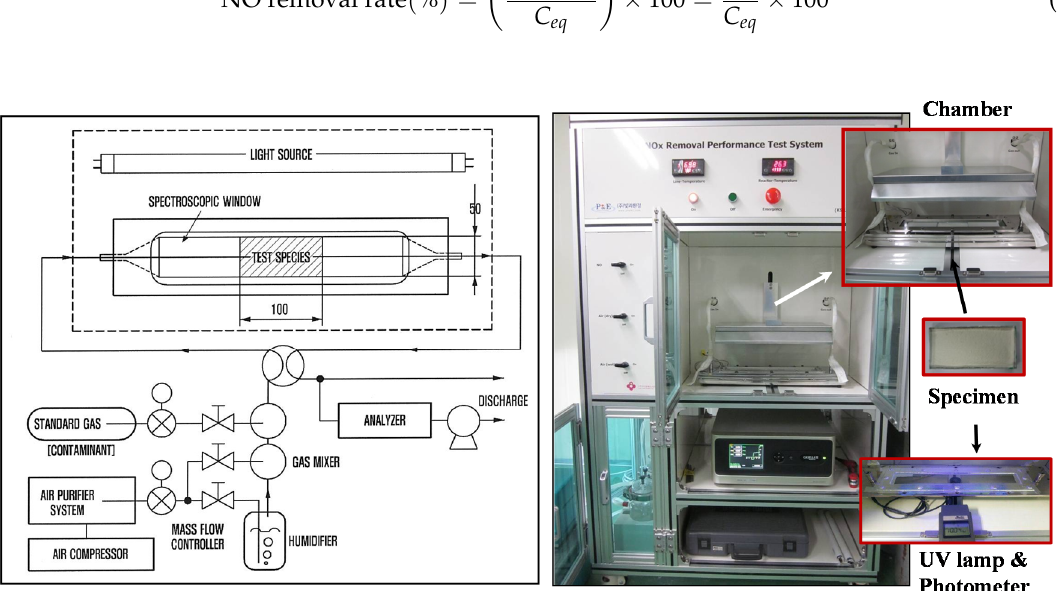
Figure 6. Apparatus meeting ISO 22197-1 specifications used to measure NO photocatalytic removal. Table 3. NO removal rates by cement paste (C) and mortar (M) (unit: μmol/(50 cm 2 ∙5 h)). Specimen